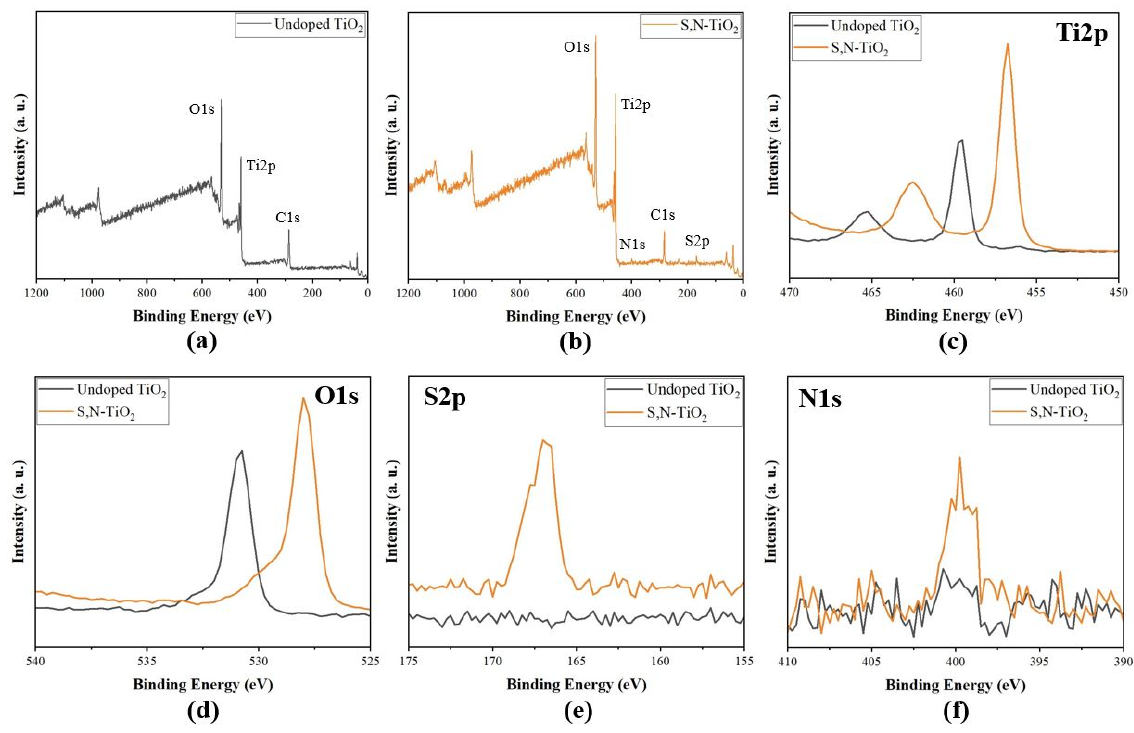
Figure 7. XPS survey spectra of ( a ) undoped TiO 2 and ( b ) S,N-doped TiO 2 . High-resolution XPS spectra of the ( c ) Ti2p, ( d ) O1s, ( e ) S2p, and ( f ) N1s regions.